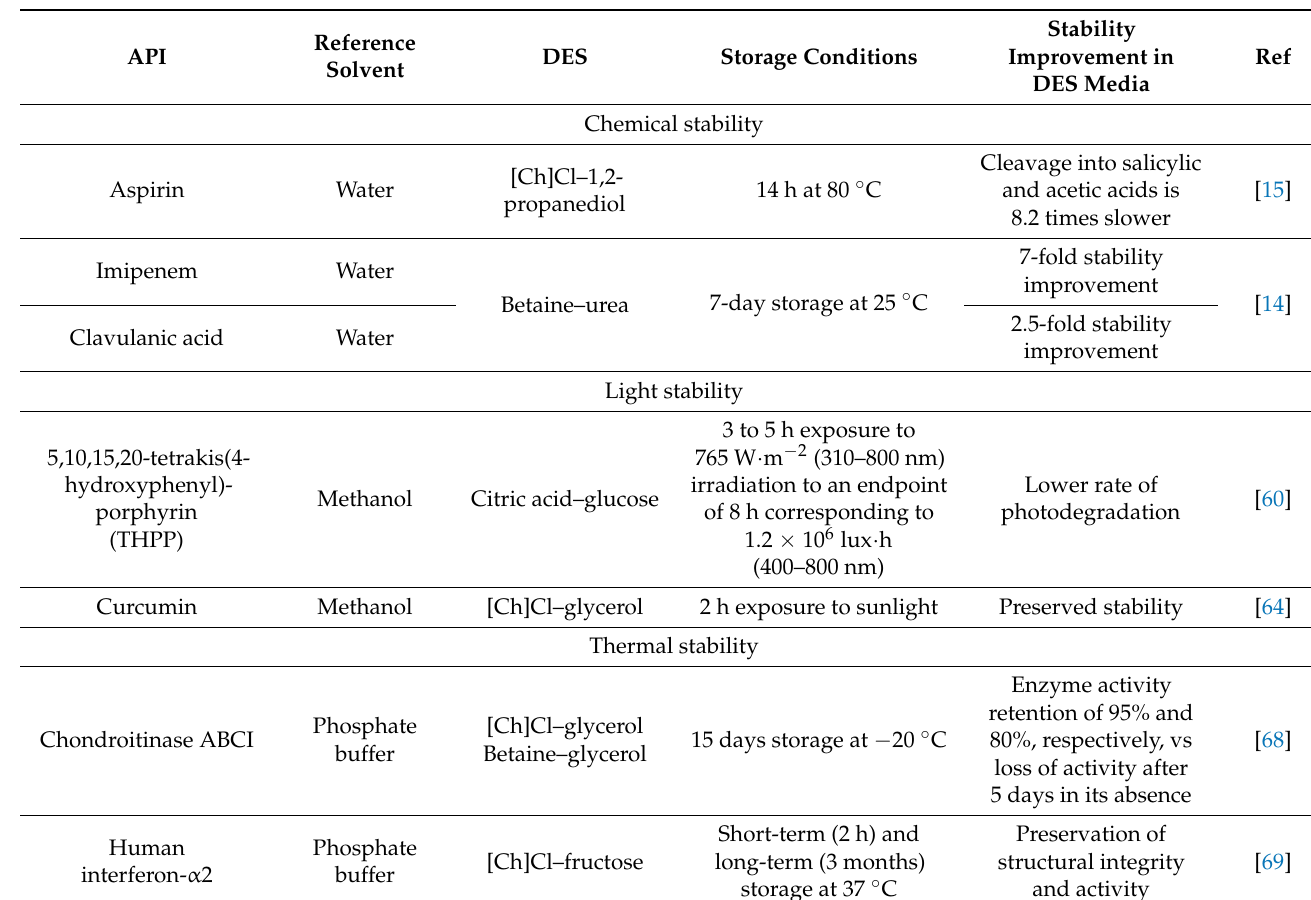
Table 3. Drug stability improvement in DES media under different storage